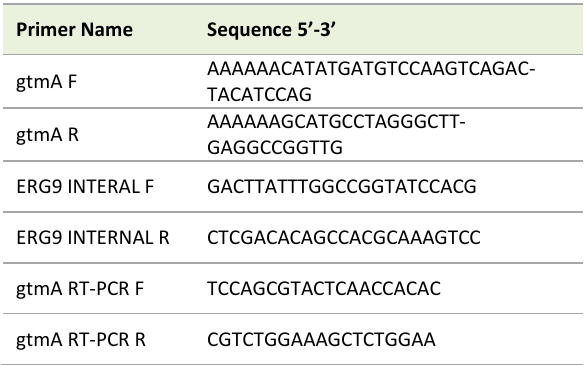
TABLE 1. Oligonucleotide primers used in this study.